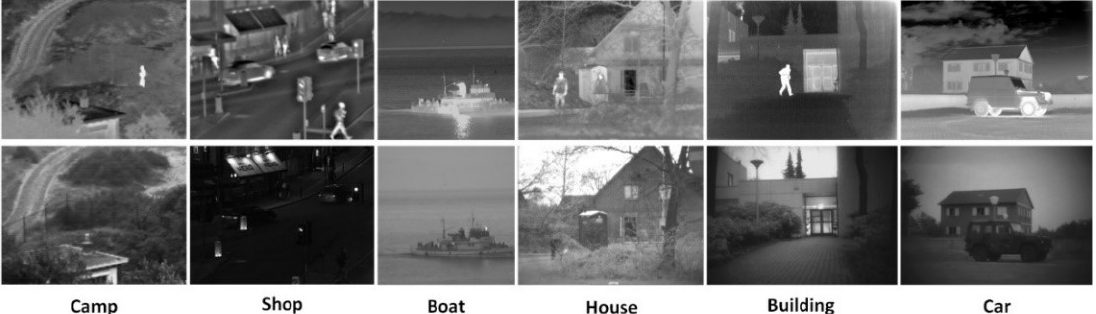
Figure 4. Six pairs of source images.